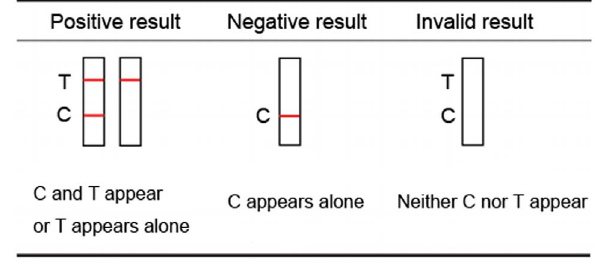
Figure 2. Interpretation of RAA-Cas13a-LFD assay results. Positive fi ndings: both test line and control line displayed or only the test line developed. Negative fi ndings: only control line visualized. Invalid results: Neither test line nor control line